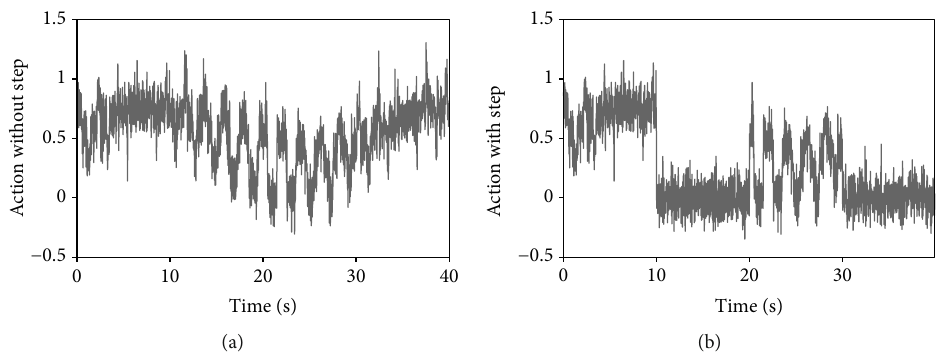
Figure 3: Accelerator pedal signal without (a) and with step factor (b).